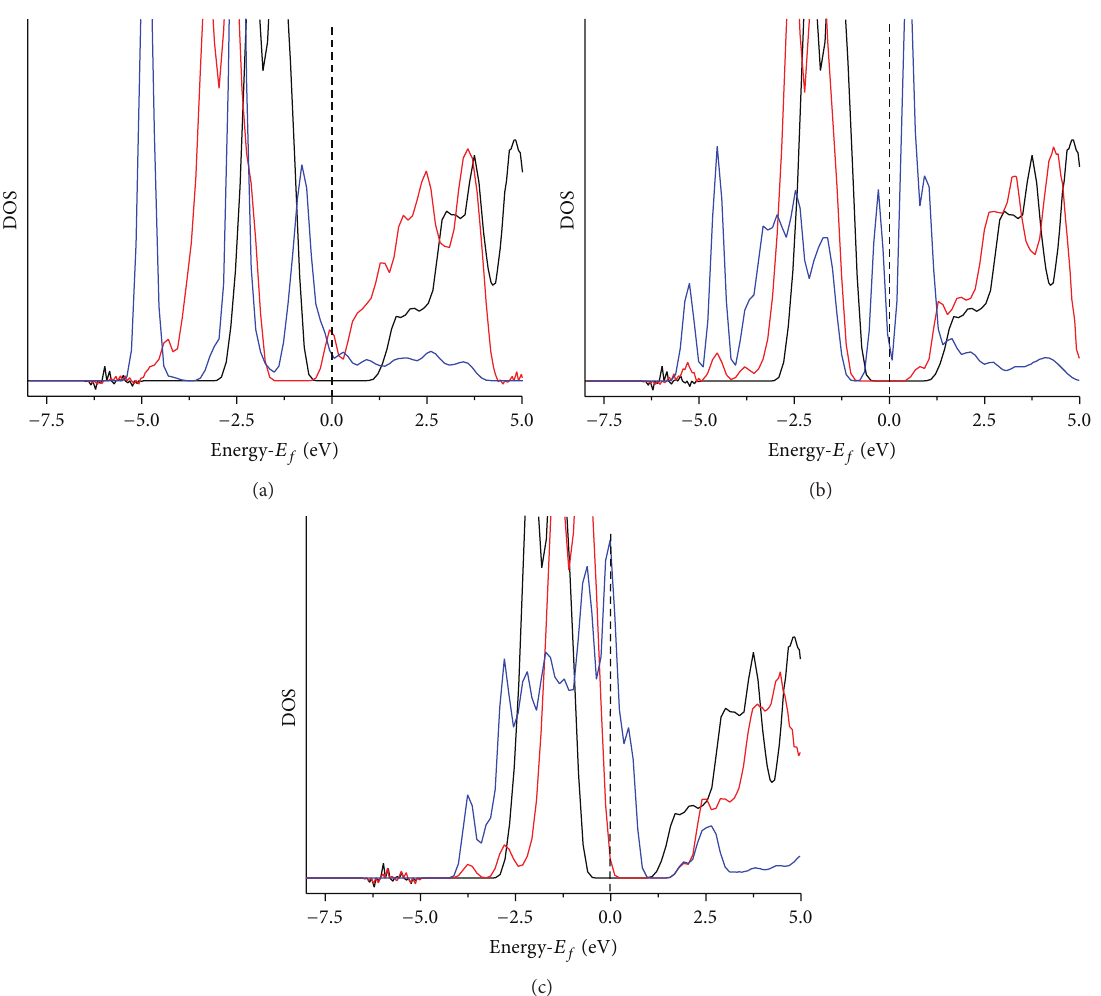
Figure 5: DOS of the V (a), Fe (b), and Ni (c) doped BaO(100) surfaces. In all cases, undoped, doped, and projected DOS of the doping atom are displayed with black, red, and blue lines, respectively. Only region near to the Fermi level is plotted for a better overview.